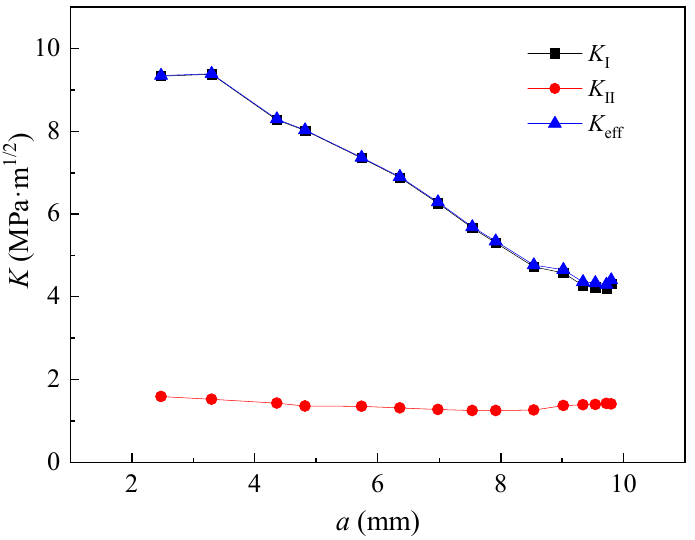
Figure 17. Stress intensity factors of W5-2 under load of 1.58 kN.